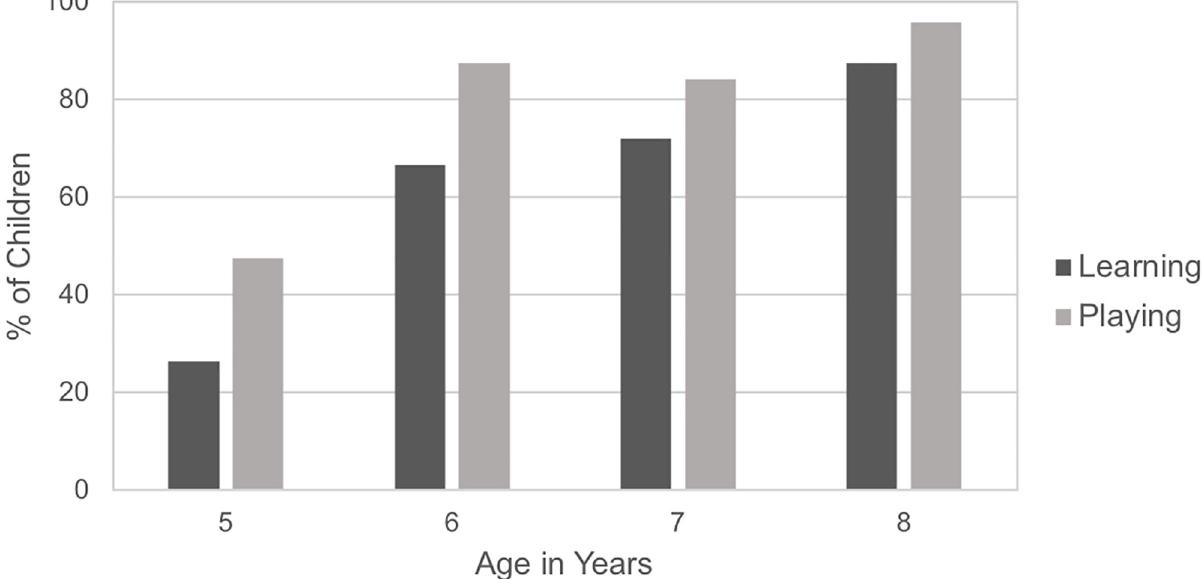
Fig 1. Percentage of children providing metacognitive definitions of learning and of playing, by age.